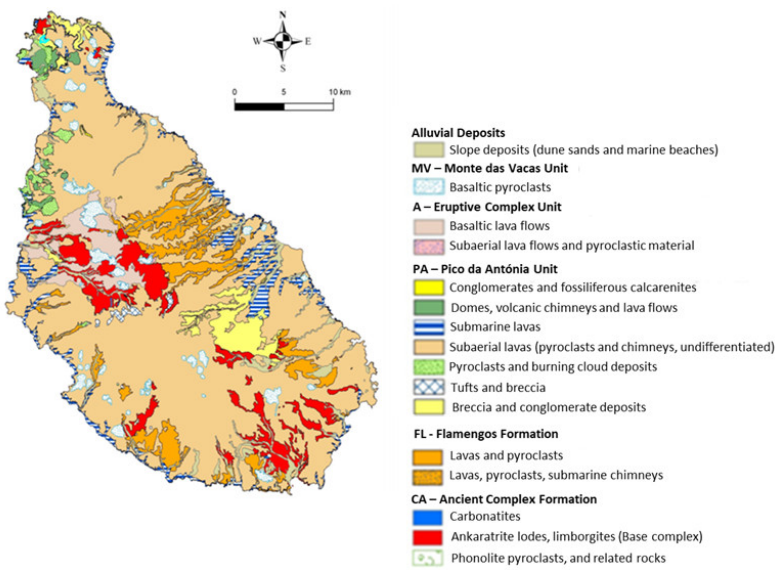
Figure 2. Santiago Island geological map. Adapted from [39].